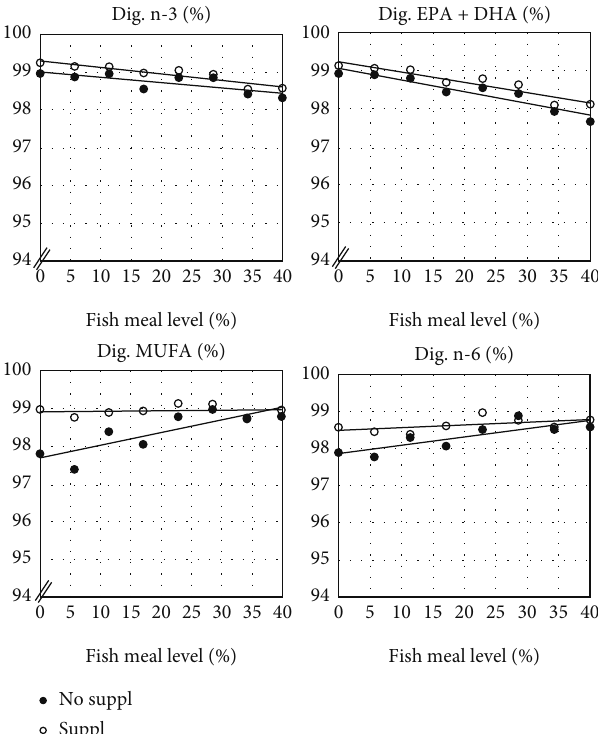
Figure 3: Digestibility of groups of fatty acid which showed a signi fi cant e ff ect of dietary fi shmeal level as well as a signi fi cant e ff ect of the dietary supplement (No Suppl and Suppl), i.e., a mixture of 0.3% choline chloride, 0.05% β -glucan and 0.05% nucleotides. Note the expanded scale on the y -axis. For statistics, see Table 4.